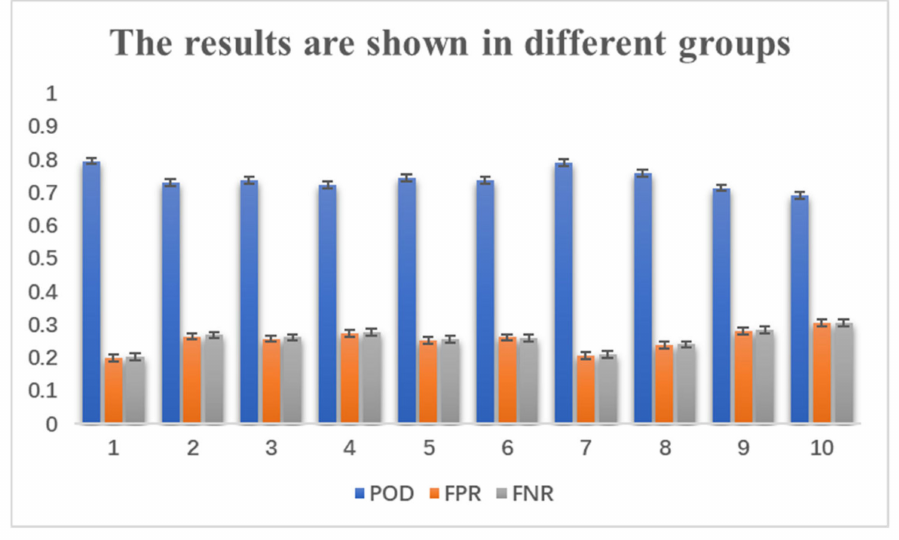
Figure 7. The results are shown in different